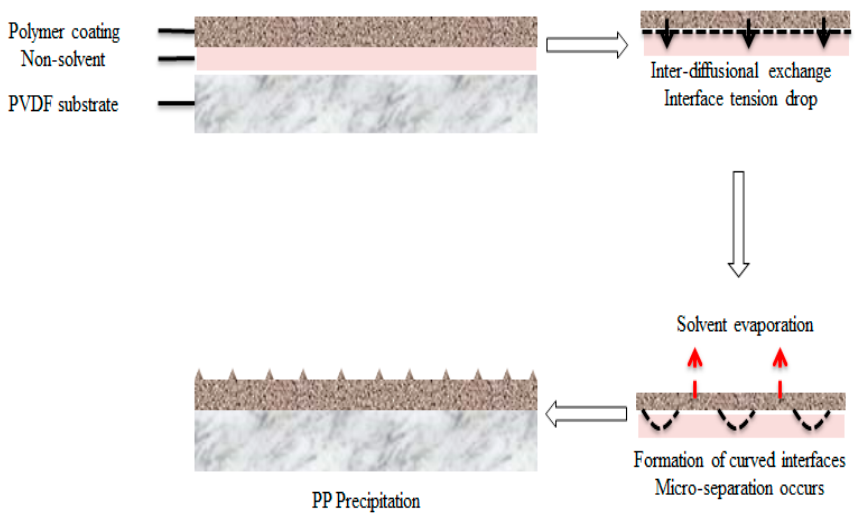
Figure 3. Precipitation of a polypropylene (PP) coating from the non-solvent–solvent interaction on the PVDF hollow fiber surface.